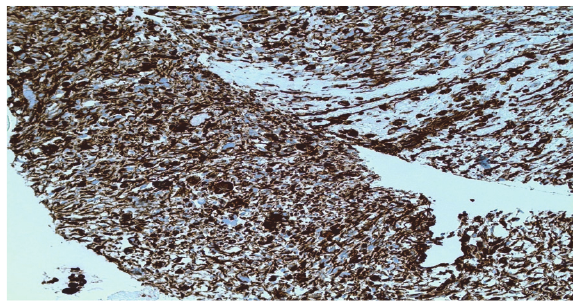
Figure 7: Vimentin positive stain (high power, H&E).